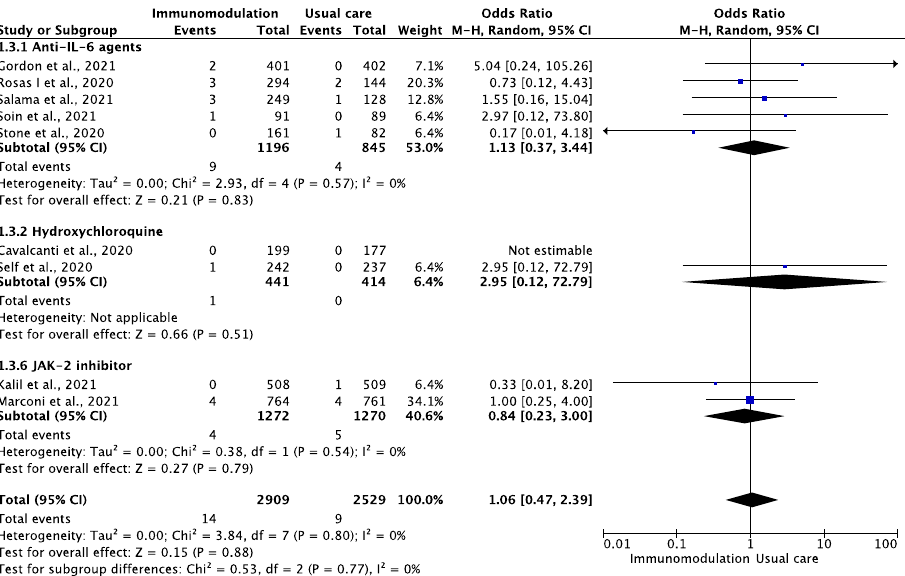
represent the pooled ORs and the 95% CIs, respectively. CI, confidence interval for the Mantel– Hansen estimator, I 2 : heterogeneity .